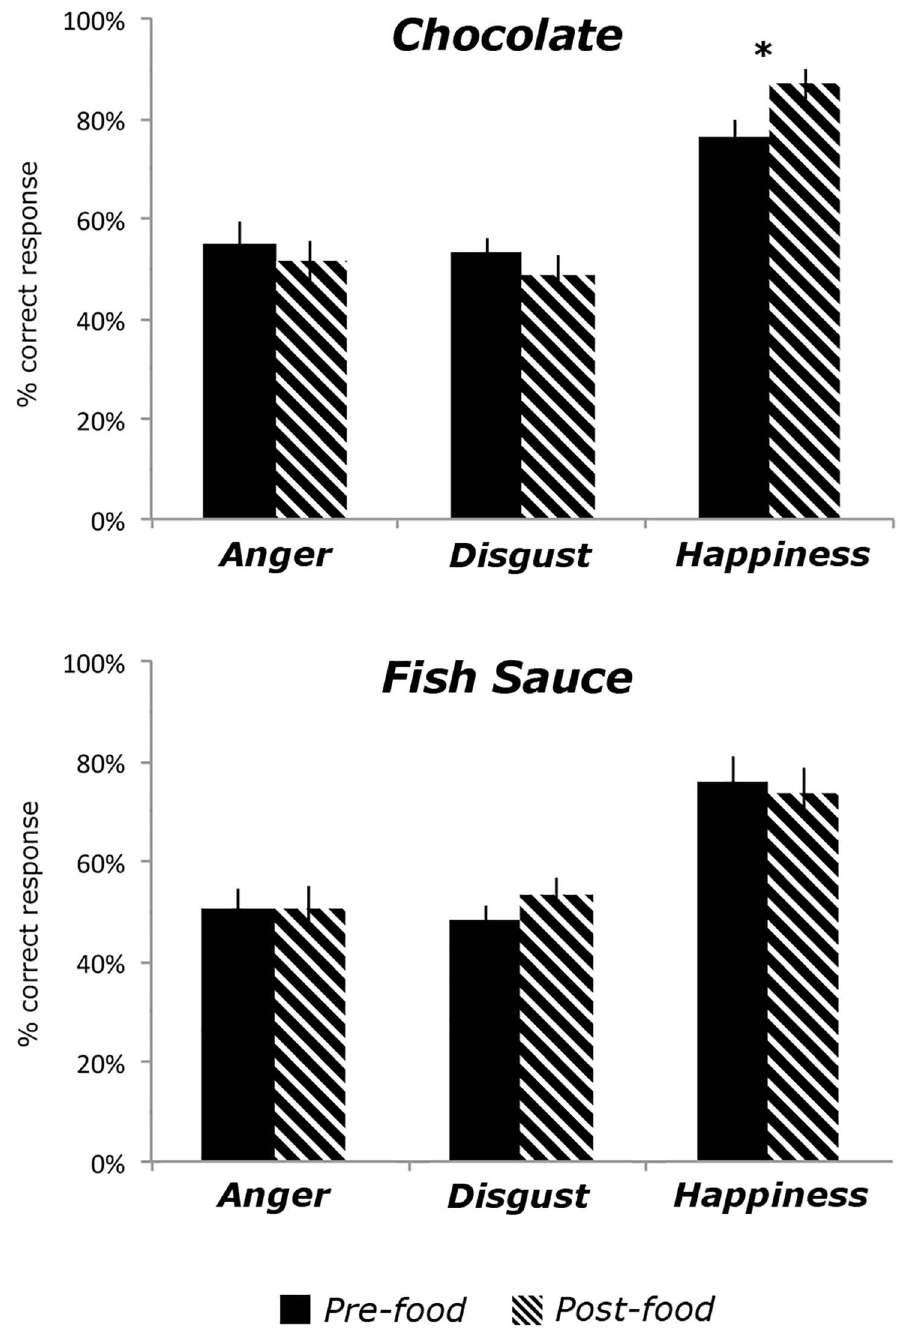
Fig 2. Results for the Emotion Recognition Task. Graphs showingperformance on the emotion recognition task, before and after either dark chocolate(top panel)or fish sauce (bottom panel)intake. Accuracy in recognizing angry, disgustedor happyfacial expressions were measured(percentageof correct responses, y axis). Error bars reflect standard error of the mean, and asterisk indicatesp < 0.05,